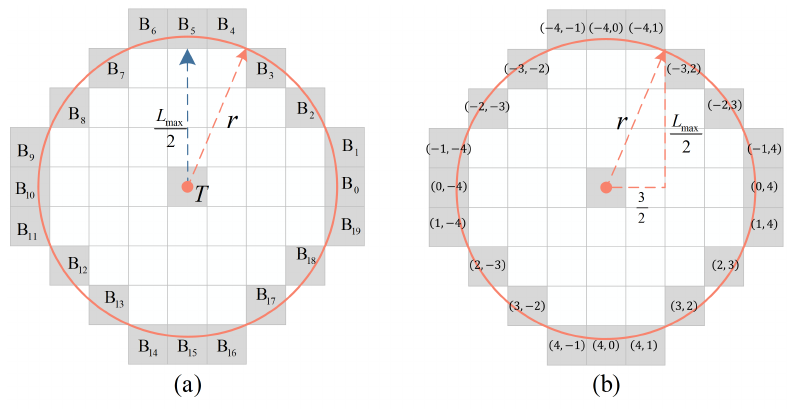
Figure 3. The structure of the circular kernel when L max = 7. ( a ) The central point T and each surrounding point B λ in the circular kernel. ( b ) The corresponding coordinate ( p λ , q λ ) of each point in ( a ).